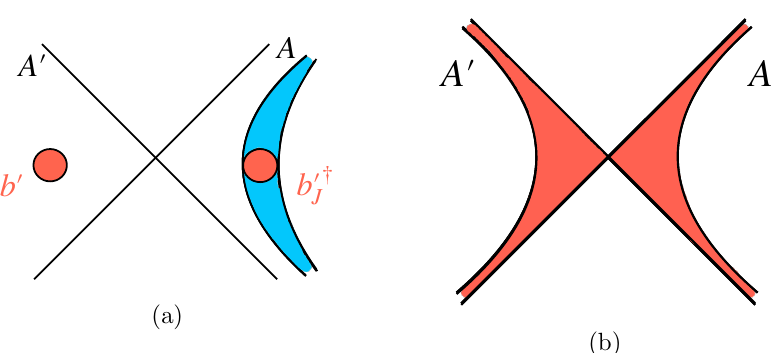
) y is also localized in the red J